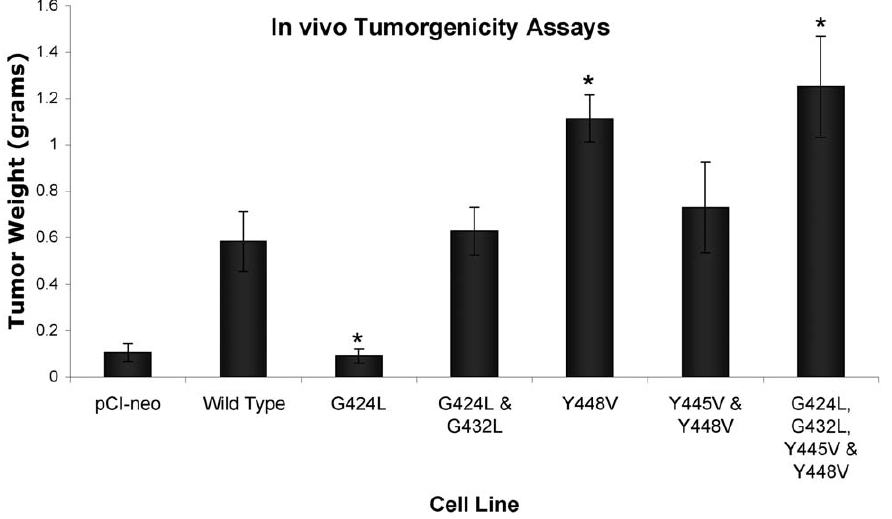
Figure 8. Tumorigenicity of 253T-NT Transfected with WT and Mutated CEACAM1-4S. Three nude mice were injected in the front flanks with each subline of 253T-NT (6 injection sites for each cell line). At three weeks after injection, tumor nodules were harvested and weighed. Columns marked with an asterisk indicate cell lines that according to P values (p , 0.05) were significantly larger (Y448V and the quadruple mutant) or smaller (G424L) than 253T-NT cells expressing wild type CEACAM1-4S. Although the effects of mutations were not as clear-cut as those observed for growth in soft agar, the G424L mutation compromised and the Y448V or the quadruple mutation enhanced the ability of CEACAM1-4S to produce tumors in nude mice.